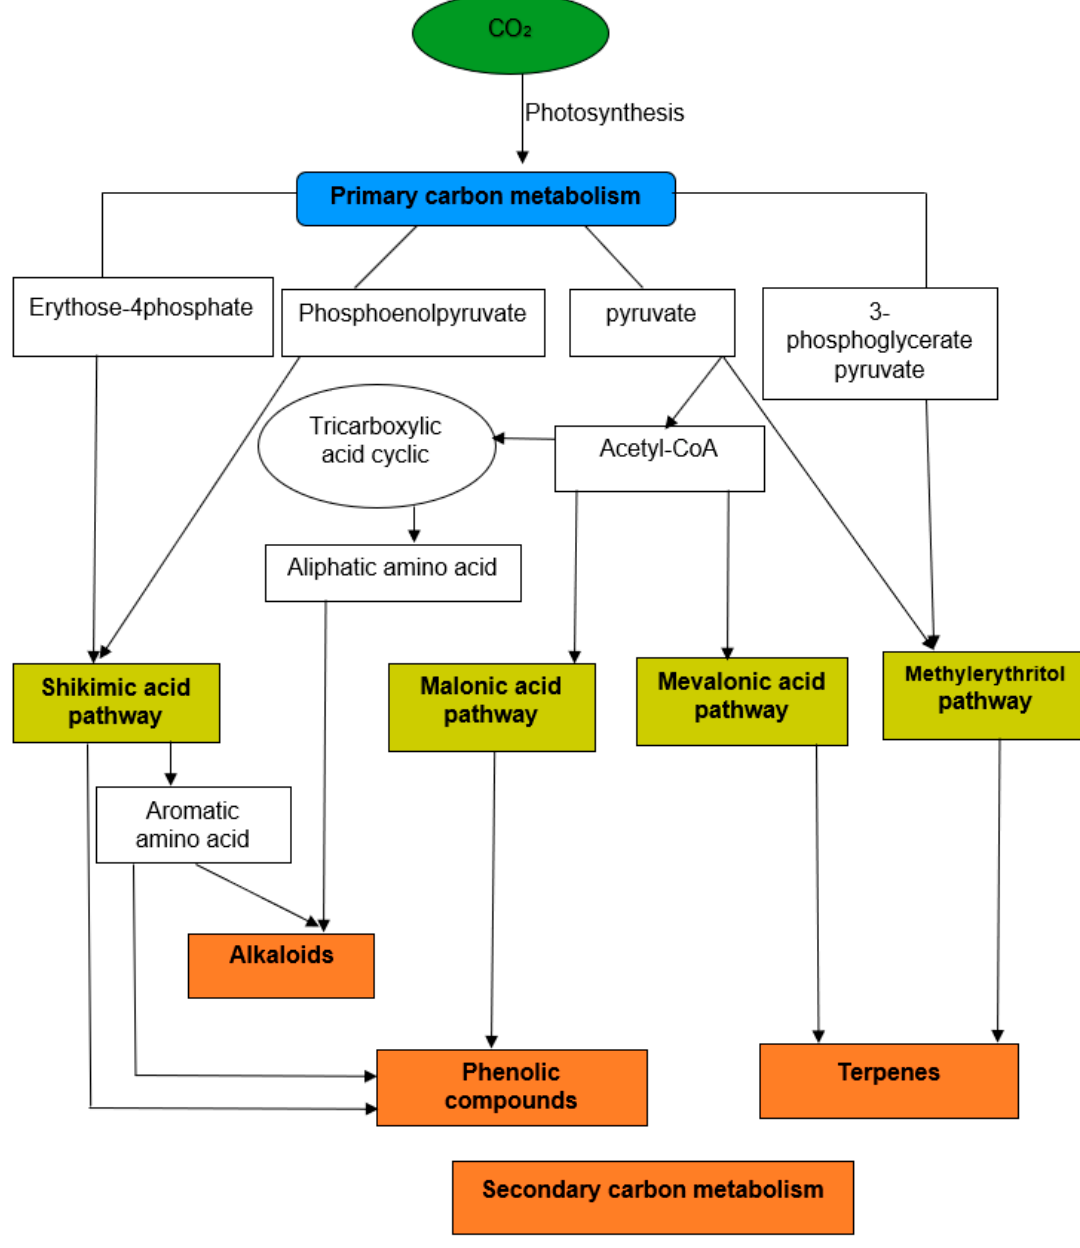
Figure 2. A general overview of the biosynthetic pathways involved in the biosynthesis of secondary metabolites (main categories of bioactive compounds) and their inter-relationships with primary metabolism in plants [3].